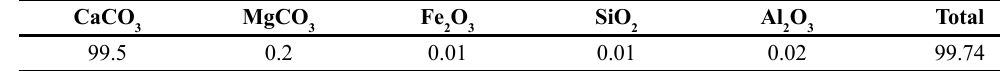
Table 1. Chemical composition of the calcite sample (wt%)